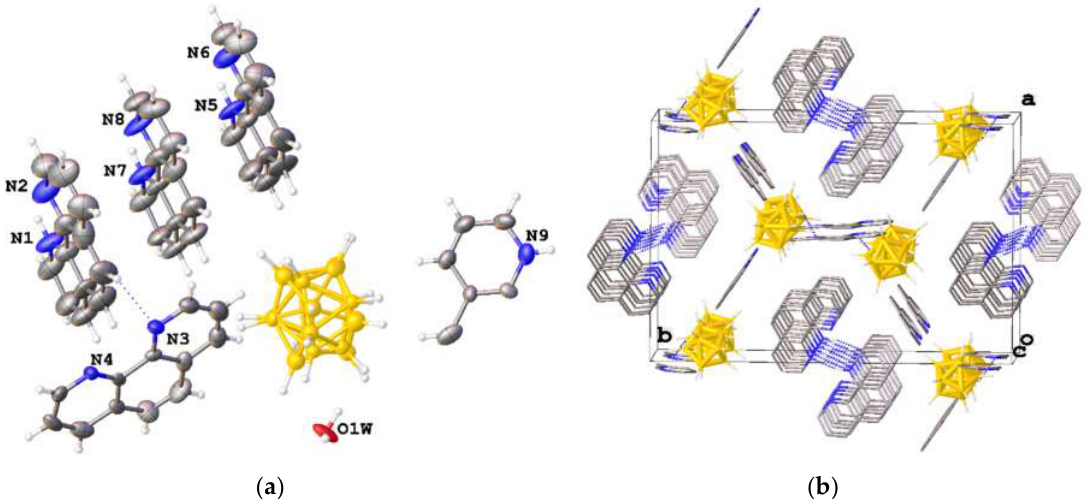
Figure 6. ( a ) Asymmetric unit of 6 ∙ 0.5H 2 O in representation of atoms with thermal ellipsoids (p = 50%). ( b ) Fragment of unit cell of 6 ∙ 0.5H 2 O along crystallographic axis c. H(C) atoms are omitted, N-H...N bonds are dashed.